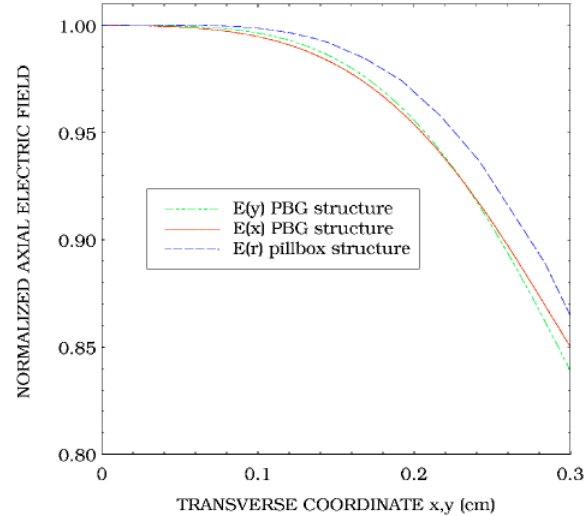
FIG. 7. Transverse accelerating field distributions near the axis in the 2 p (cid:1) 3 PBG and pillbox